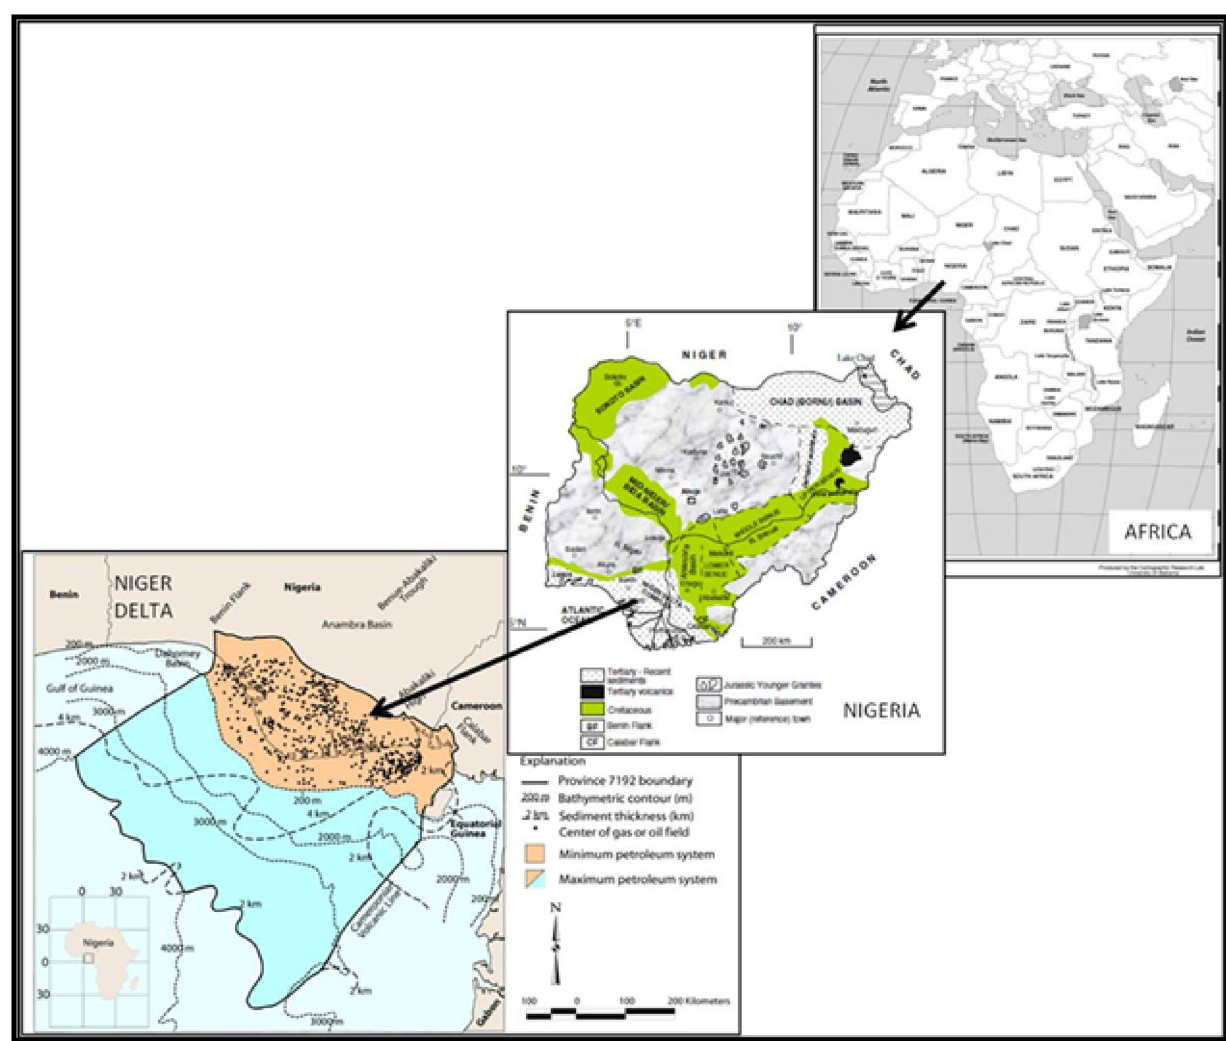
Fig. 1 Group of maps: Africa, Nigeria (modified from Obaje 2009) and Niger